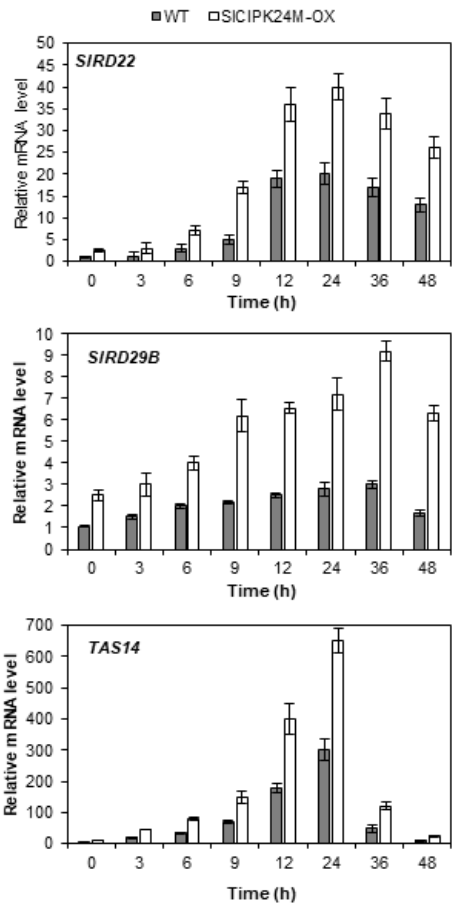
Figure 7. Expression levels of Stress Marker Genes in WT and SlCIPK24M-overexpressing tomato plants under 200 mM NaCl stress at different times. Eleven-day-old plants were treated with 200 mM NaCl for the indicated time period. The expression levels of SlRD22 (Solyc08g068150.4.1), SlRD29B (Solyc03g025810.4.1) and TAS14 (X51904.1) in WT at 0 h were set to 1.0 to show relative abundance differences. The tomato actin7 and β -tubulin genes were employed as internal control. Error bars denote standard deviation (SD) of the means produced from three independent experiments. Values are significantly different (the Student’s t -test, p ≤ 0.05).